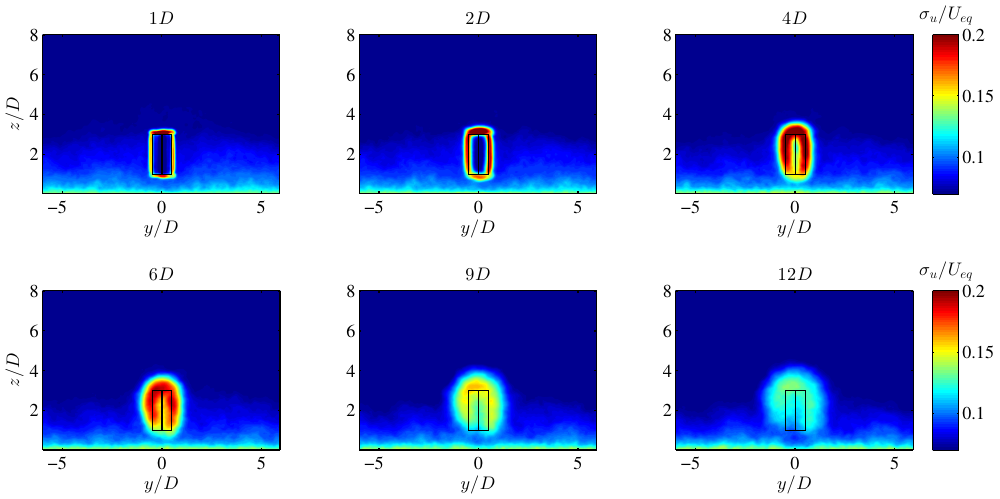
Figure 12. Contour plots of the streamwise turbulence intensity, σ u / U eq , in six different y - z planes at different distances downstream of the center of the